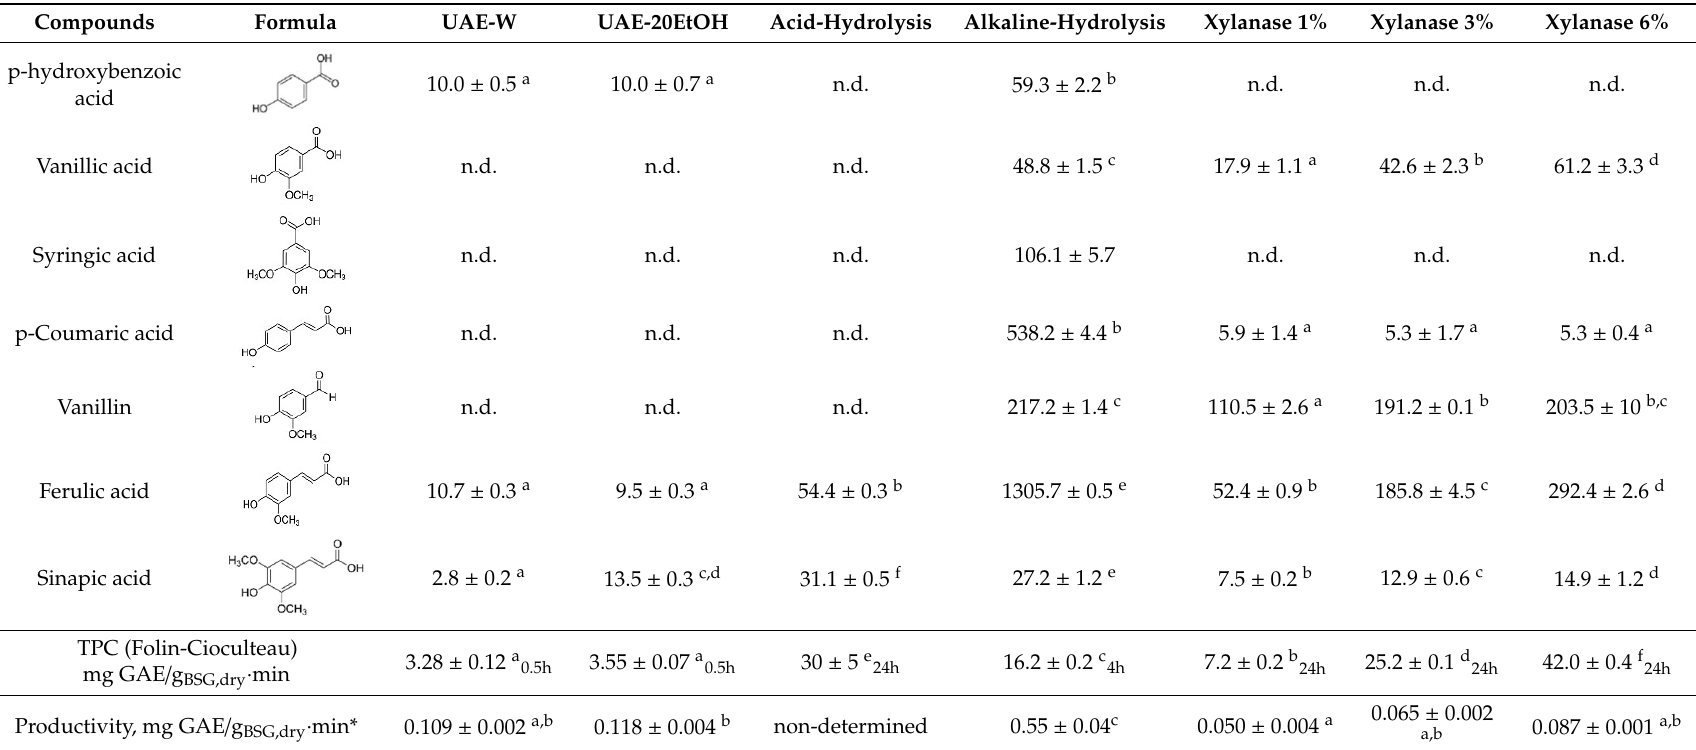
n.d.: non detected. Values with different letters (a–f) in each raw are significantly different when applying the Fisher’s least significant differences (LSD) method at p -value ≤ 0.05. * evaluated after 30 min of extraction.